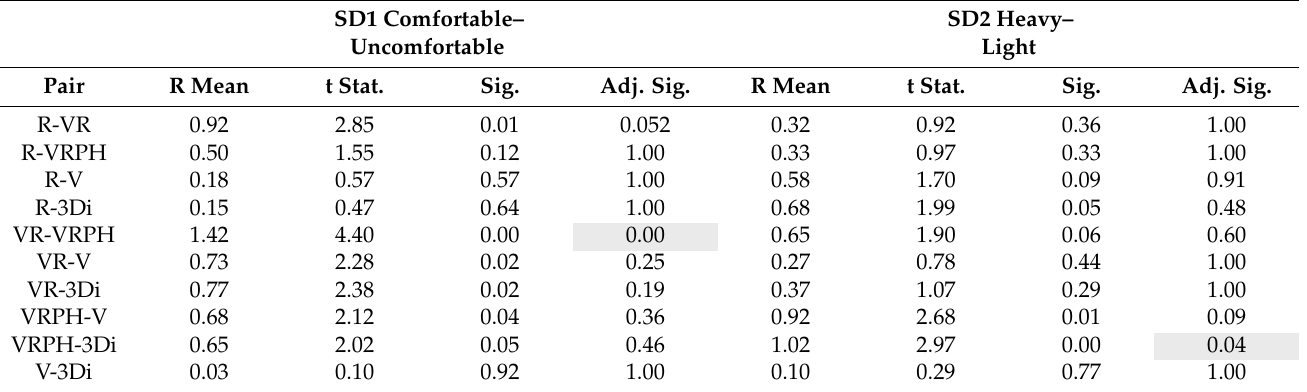
Table 5. Adjusted significance levels for the SD1 and SD2 pairwise comparisons. Grey areas denote statistically significant differences.